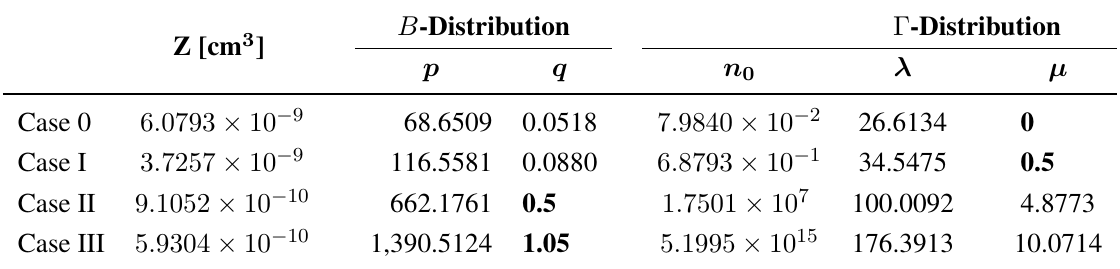
Γ -Distributions with certain parameter values (bold), which are helpful for the